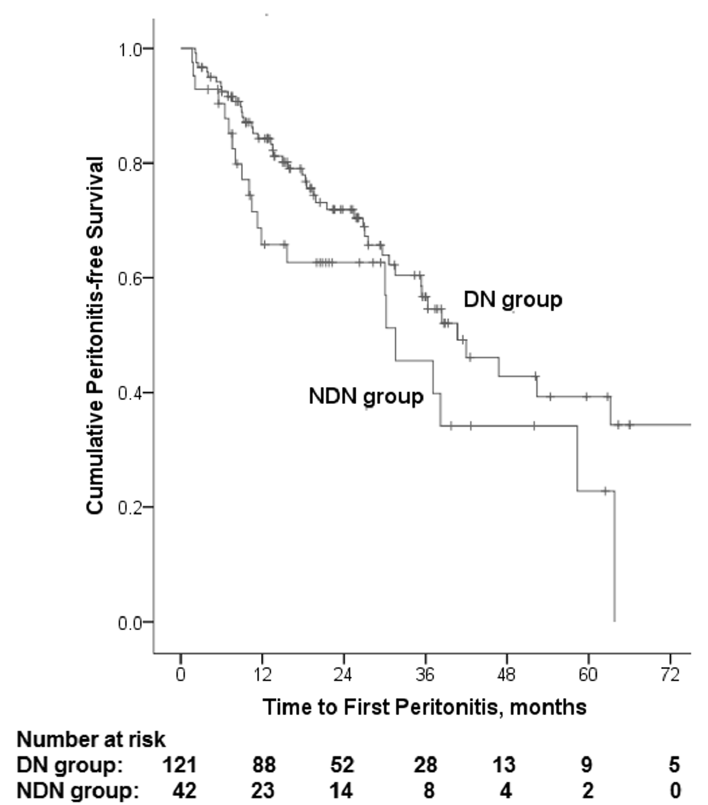
Fig 3. Kaplan — Meier survival analysis for time to first peritonitis episode. Kaplan — Meier analysis showed that NDN group had a marginally worse peritonitis-free survival compared with DN group (log rank 3.297, P =